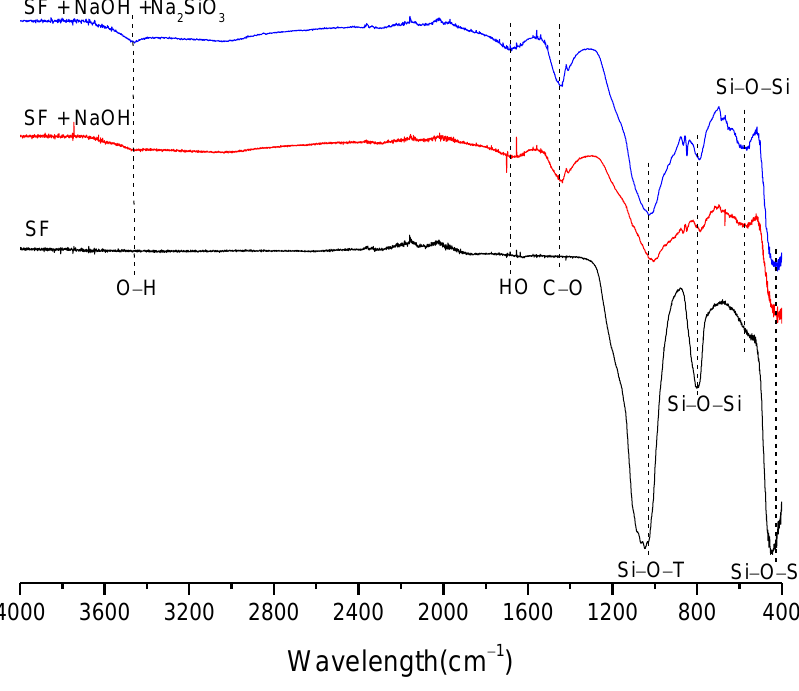
Figure 5. FTIR of SF and SF activated pastes.